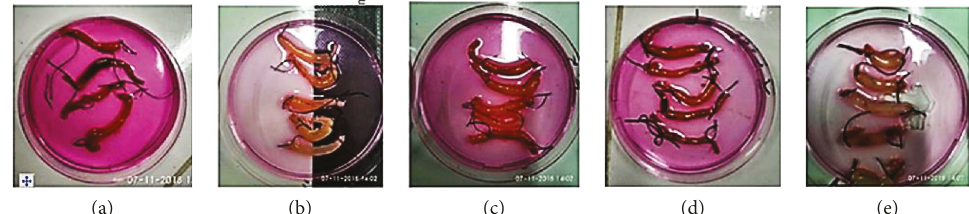
Figure 3: Macroscopic intestinal weight changes of mice vaccinated with V. cholerae -infected MLIL method. (a) The first group was the negative control group. (b) The second group we infected with S. flexneri . (c) The third group was the same as the second group, but the sample group was infected with V . cholerae . (d) The fourth group was immunized before being affected by S. flexneri . (e) The last group is the same as the fourth group but infected with V . cholerae